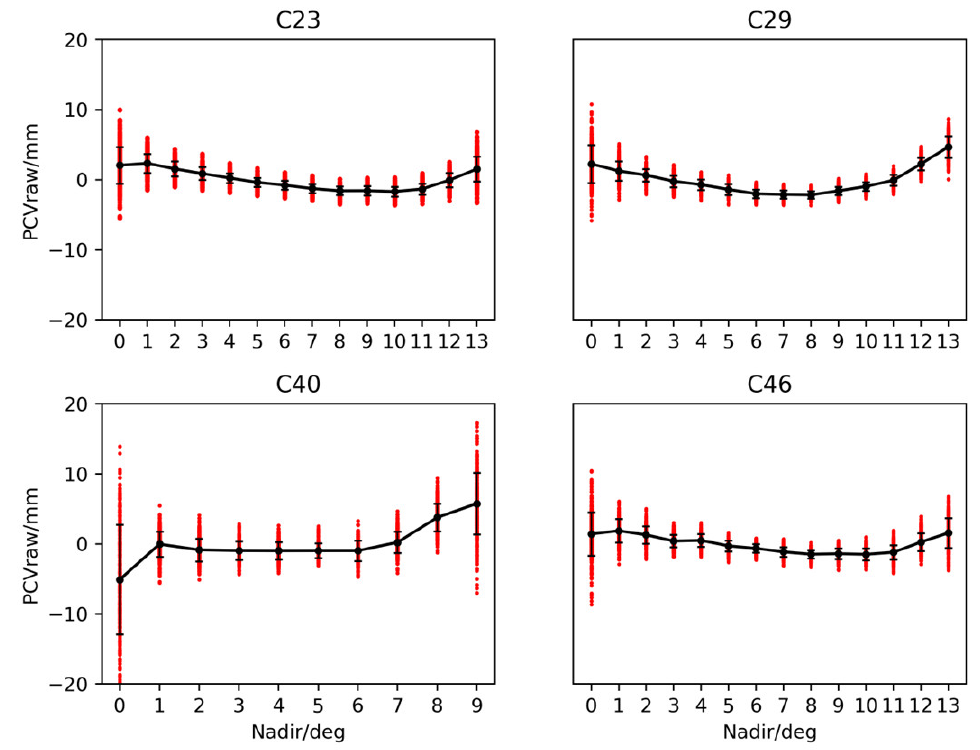
Figure 7. The daily PCVraw of C23, C29, C40, and C46, respectively.